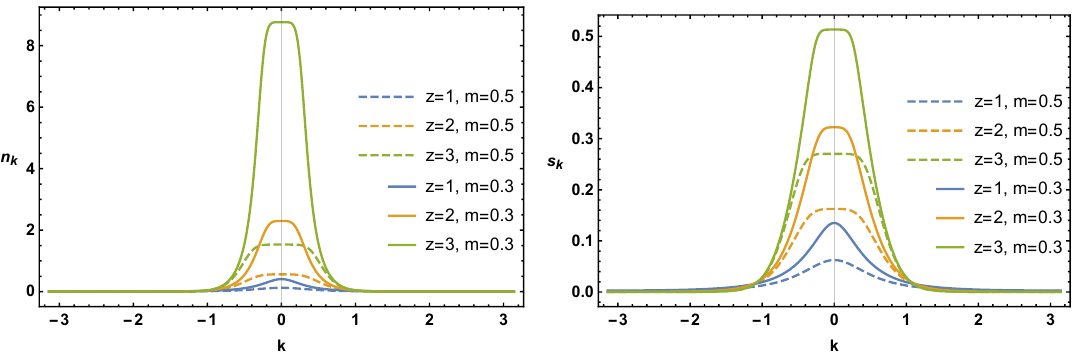
Figure 4 . Mode occupation number and entropy density as a function of k for di(cid:11)erent values of the dynamical exponent. Here we set m 0 = 1. We have shown two values of post-quench mass to see how fast the n ( k ) and s ( k ) diverge for small values of mass. Comparing these two values of m gives a sense of how fast the occupation number (and entropy density) diverge in the massless limit. The same behaviour is correct for (cid:12)xed post-quench mass and small pre-quench